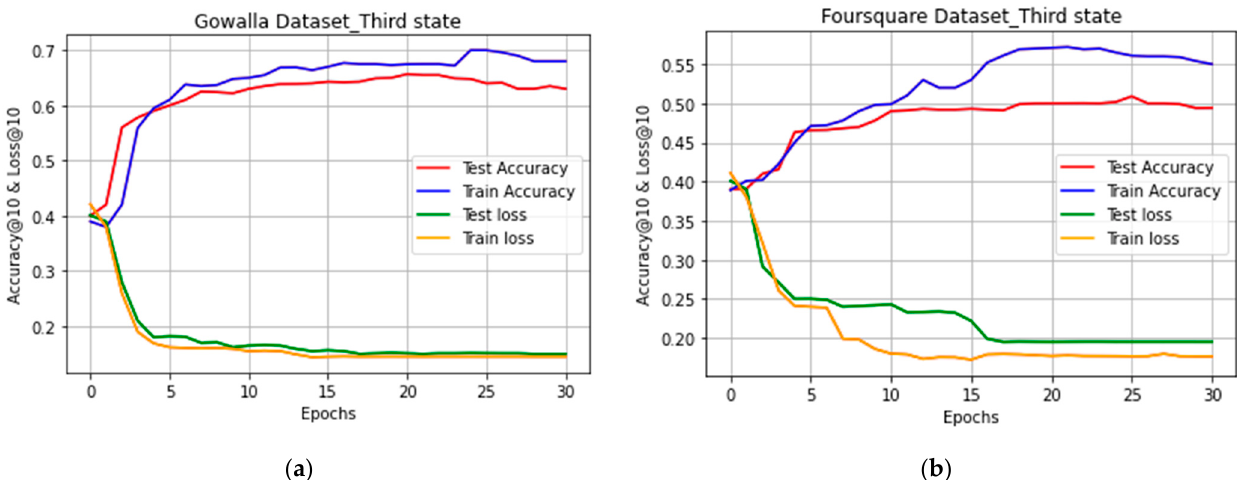
Figure 10. Training and testing accuracy @10 and loss @10 for two datasets vs. epochs in the third state of experiments. ( a) Gowalla dataset; ( b ) foursquare dataset.